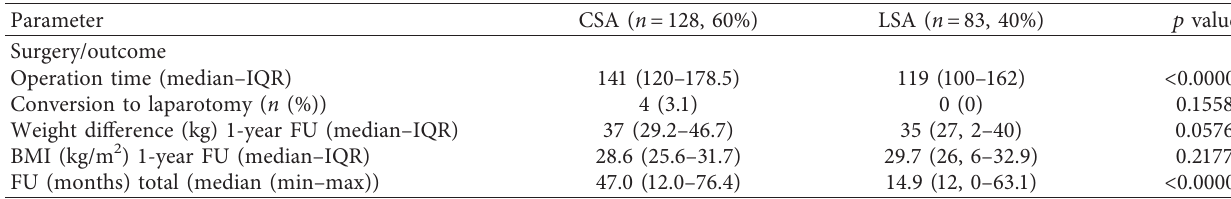
Table 3: Surgery/outcome.